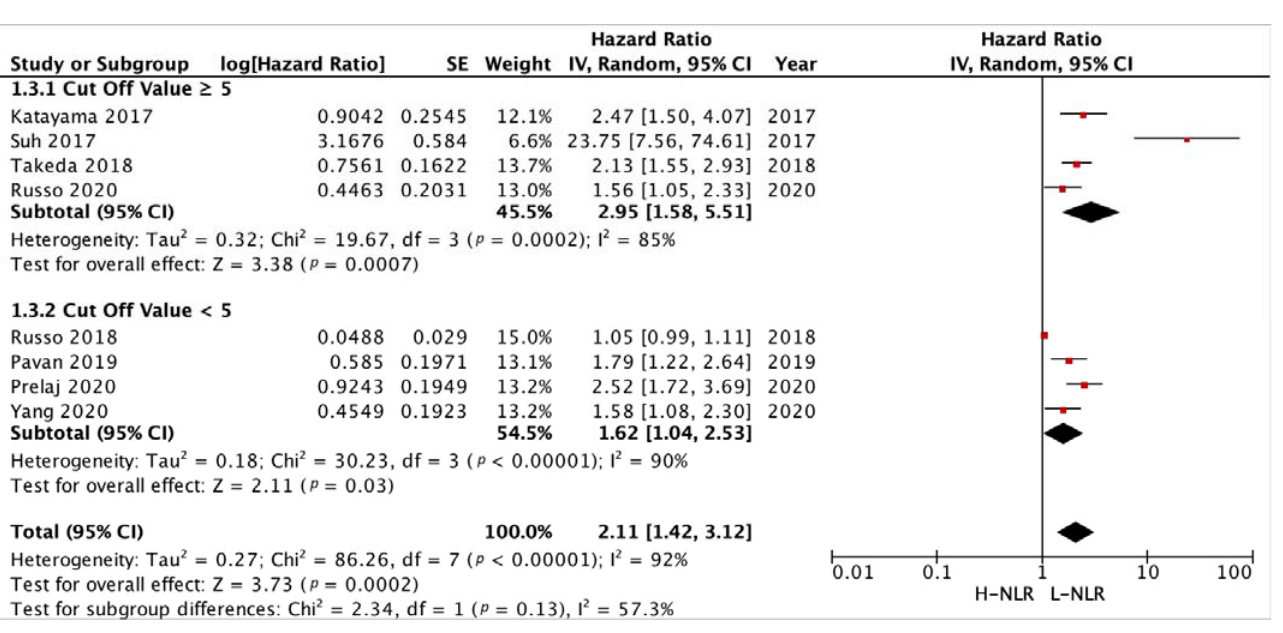
Figure 8. Forest plot cut-off value subgroup analysis of H-NLR versus L-NLR to PFS in patients treated with immunotherapy. Red dots represent study weights; the bivalve represent the overall effect.